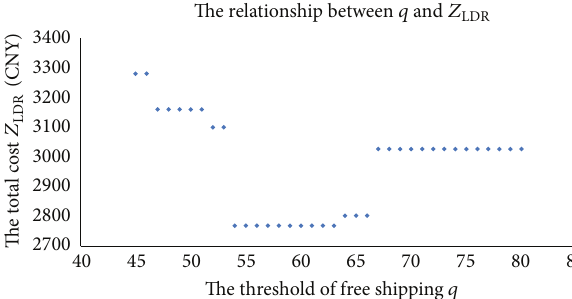
Figure 1: The detailed relationship between threshold and the optimal